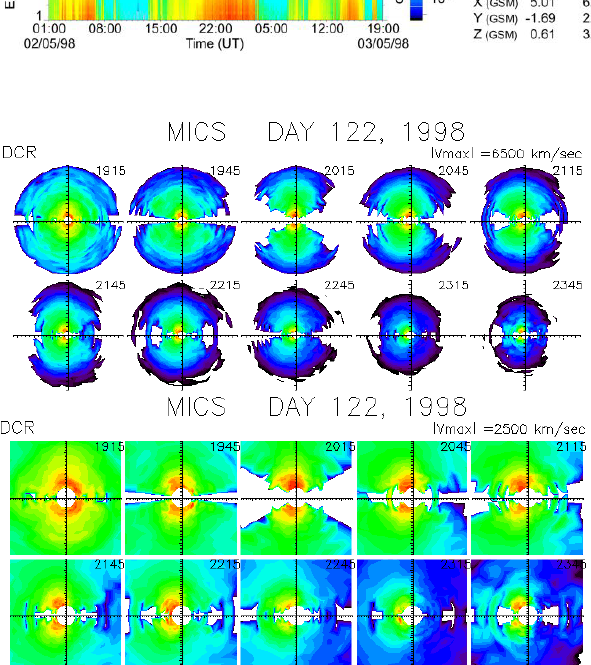
Fig. 4. The intensity of the ion species, H + , He ++ , He + , O + , and high charge state O, as a function of particle en- ergy for the period of 2 and 3 May 1998. Note the three periods in which an extended signature of high charge- state 1–10keV ions was seen along the trajectory of the Polar satellite. The or- bit projected onto the SM XZ -plane is also shown with an indication of where these extended signatures are seen. For the interval of Period 3 in Table 1 an inset showing the variation of the to- tal magnetic field is shown (courtesy of C. T. Russell), demonstrating the de- pressed magnetic field associated with the extended signature of high charge- state ions.